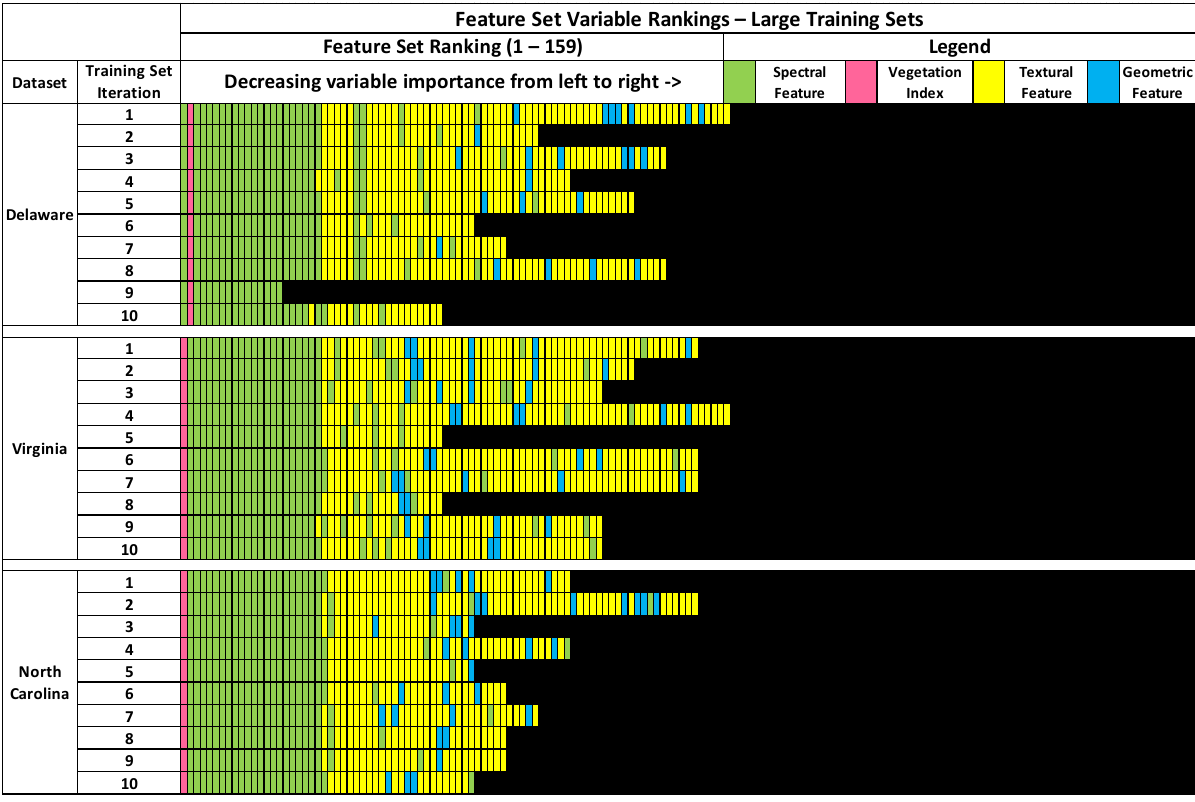
Figure 5. RFE ‐ derived feature set rankings for large Delaware, Virginia, and North Carolina training sets. Each row indicates the features that were found to be optimal for the training set by the RFE process. Each cell indicates the type of feature that was included in the RFE ‐ derived feature set, ranked in decreasing importance to the accuracy of the classification from left to right.